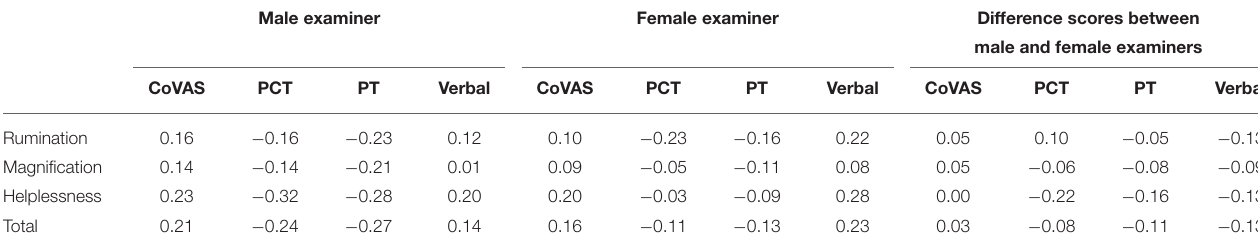
TABLE 2 | Correlations coefficients (R) between pain catastrophizing subscales and pain measurements adjusted for multiple comparisons (Bonferroni). Male examiner Female examiner Difference scores between male and female